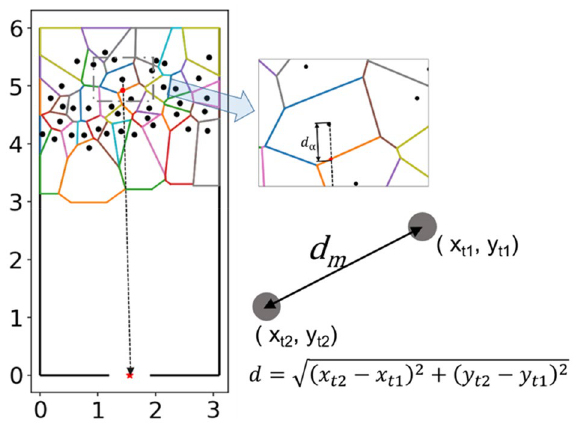
Figure 2. Definition of motion activation time calculation method. Black points represent the positions of each pedestrian in the first frame. Voronoi diagrams represent the space each pedestrian takes up at this time. The red star represents the middle point of the exit and we assume that each pedestrian moves towards the target at the beginning of the experiment. The red point represents the intersection between the moving target and the boundary of the pedestrian’s occupied space. The distance d a between the pedestrian position and the intersection represents the personal available distance. The grey solid circles represent an individual at two different time in an experiment. d m represents the movement distance calculated by the coordinate of the individual. When d m > d mth , the time is set as the moving time t m . When d α > d α _ threshold , the time is set as